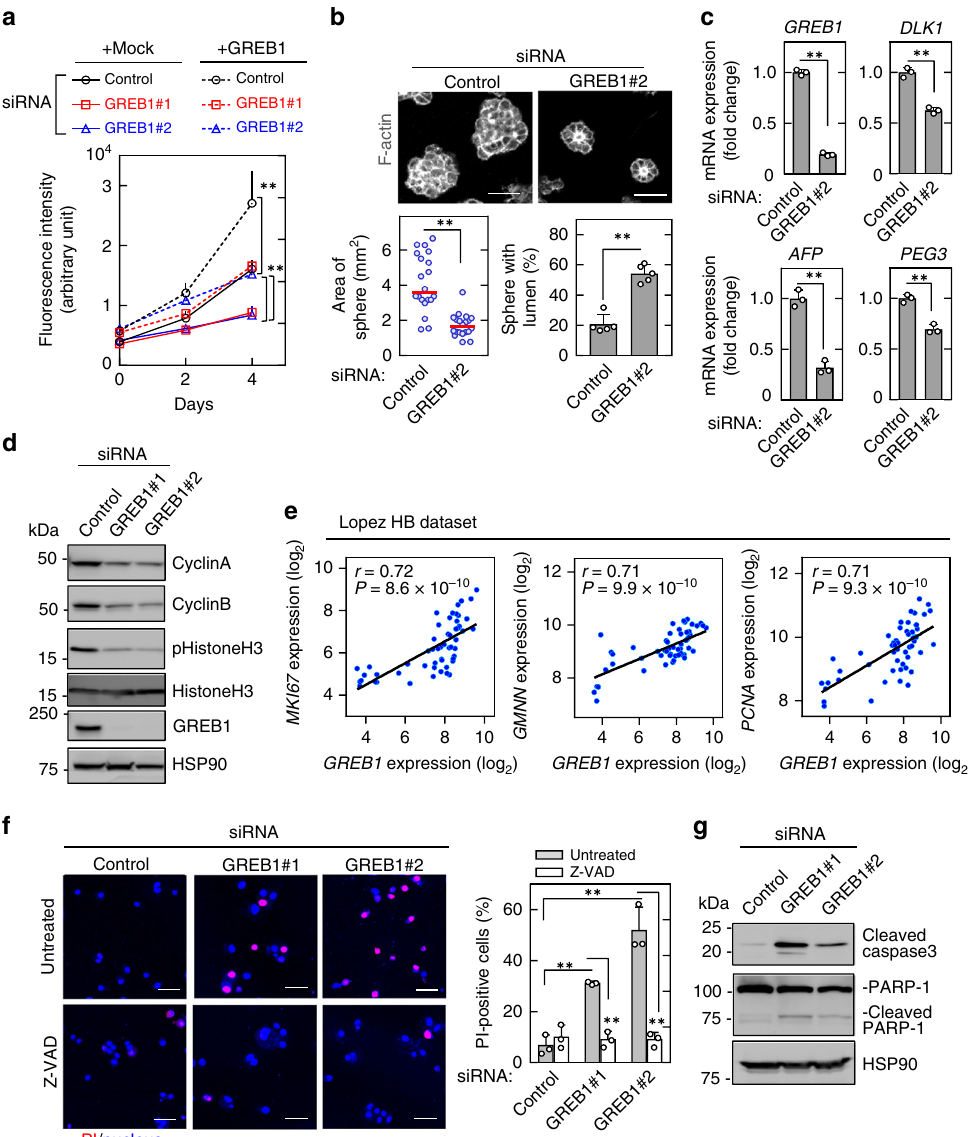
Fig. 2 GREB1 expression is involved in HB cell proliferation in vitro. a HepG2 cells expressing mock or GREB1 were transfected with control or two independent GREB1 siRNAs and cultured on a 2D plastic dish for the indicated numbers of days. Relative cell numbers were quanti fi ed using the Cyquant assay. Results are shown as means ± SD. ** P < 0.01, ANOVA and post hoc test. b HepG2 cells transfected with control or GREB1 #2 siRNA were cultured for 5 days in 3D Matrigel. Cells were then stained with phalloidin, and areas of spheres were calculated; results are shown as dot plots with median ( n = 20). Spheres with polarized lumen are expressed as the percentage of spheres with F-actin-positive central microlumen compared with the total spheres. The results shown are means ± SD ( n = 50). ** P < 0.01, t test. c HepG2 cells were transfected with control or GREB1 #2 siRNA and real-time PCR experiments for indicated mRNA expression were performed. ** P < 0.01, t test. d HepG2 cells were transfected with control or two independent GREB1 siRNAs and cultured in medium with 0.1% FBS for 24 h. Lysates were probed with the indicated antibodies. e Scatter plots showing correlation between marker genes of cell proliferation ( Y -axis) and GREB1 gene expression ( X -axis) were obtained from the dataset of HB. r value and P value were calculated with GraphPad Prism 7. f HepG2 cells were transfected with control or two independent GREB1 siRNAs and cultured in medium with 0.1% FBS for 48 h with or without Z-VAD. Cells were incubated with PI and Hoechst33342. PI-positive cells are expressed as the percentage of positively stained cells compared with total Hoechst33342 stained cells per fi eld ( n = 100 – 200). ** P < 0.01, ANOVA and post hoc test. g HepG2 cells were transfected with control or two independent GREB1 siRNAs and cultured in medium with 0.1% FBS for 48 h, and the lysates were probed with the indicated antibodies. Scale bars in b , 50 μ m; in f , 100 μ HepG2 cells (Fig. 4e). GFP-Smad2/C containing the MH2 HepG2 cells, irrespective of exogenous TGF β stimulation (Fig. 4g). domain interacted with p300 in X293T cells, and overexpression Expression of constitutively active mutant of TGF β receptor 1 of HA-FLAG-GREB1 inhibited their interaction (Fig. 4f), sug- (TGFBR1 T204D ) increased the SNAIL2 and p15/CDKN2B (target gesting that GREB1 competes with p300 for binding to Smad2/3. gene of TGF β signaling) mRNA levels, and GFP-GREB1 but not The ChIP assay revealed that GREB1 knockdown increased levels GFP-GREB1/ Δ M lacking the Smad2/3-binding region inhibited of acetylated histone H4 (acH4) at the PAI-1 locus (exon2) of the upregulation (Fig. 4h). Under the same conditions, GREB1